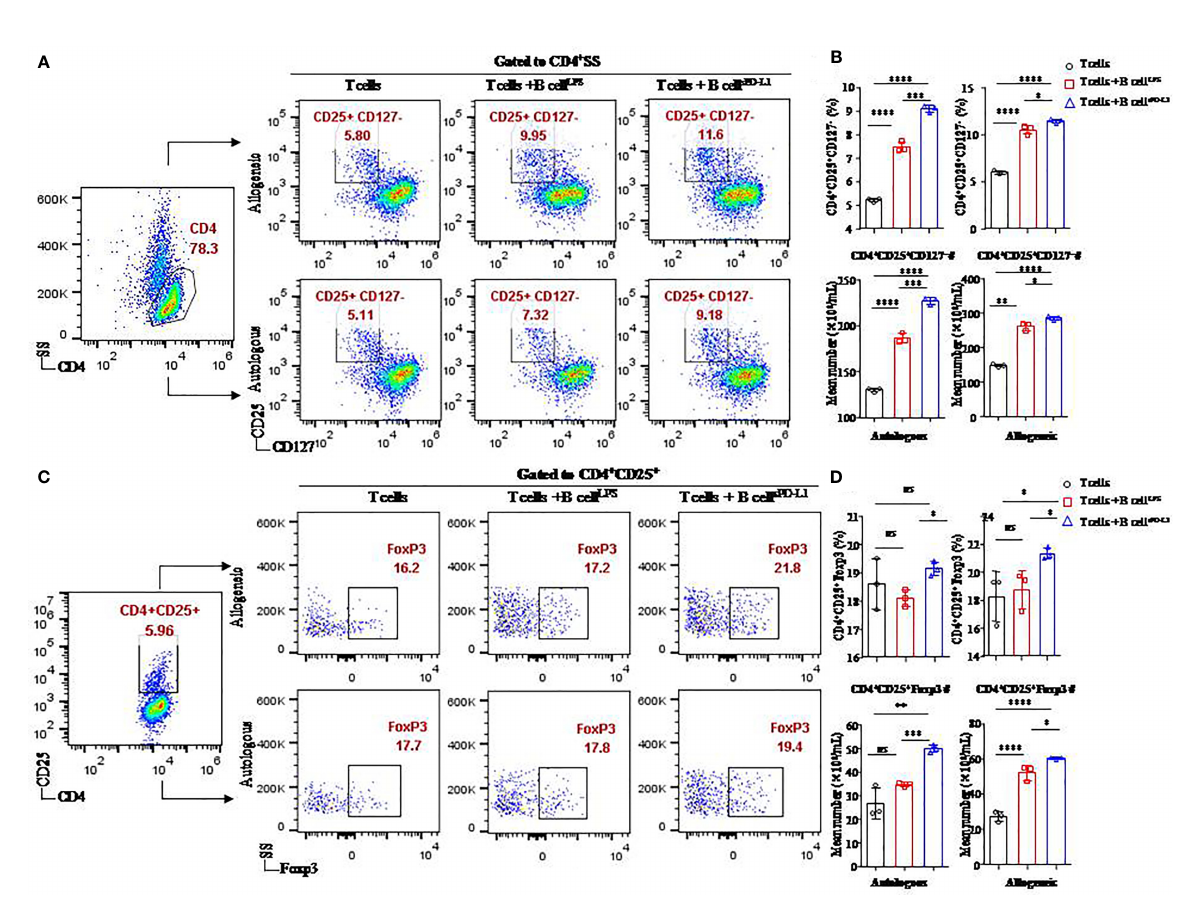
FIGURE 4 Function of CD19 + B cells stimulated by sPD-L1 in a T/B lymphocyte coculture system. Representative fl ow cytometry dot plot of CD25 + CD127 − expression in total CD4 + T cells (A) and Foxp3 expression in CD4 + CD25 + T cells (C) from autologous or allogeneic healthy individuals cocultured with CD19 + B cells pretreated with LPS or sPD-L1. The proportion and the absolute number of CD4 + CD25 + CD127 − T cells (n = 3) were measured by fl ow cytometry (B) , and the proportion and the absolute number of Foxp3 expression in CD4 + CD25 + T cells (n = 3) were measured by fl ow cytometry (D) in the B/T lymphocyte coculture system. Data represent the means ± SEM of at least three independent experiments and were analyzed by Student ’ s t -test. ns, not statistically signi fi cant. * P < 0.05, ** P < 0.01, *** P < 0.001, and **** P <